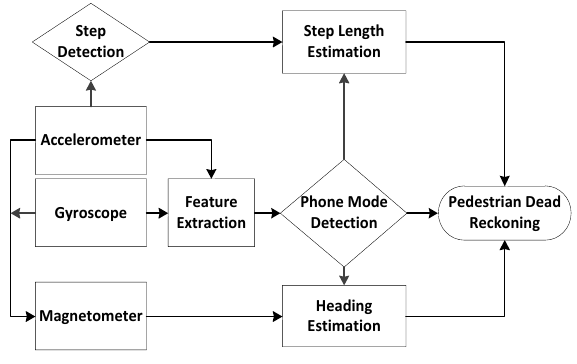
Figure 1. The architecture of the